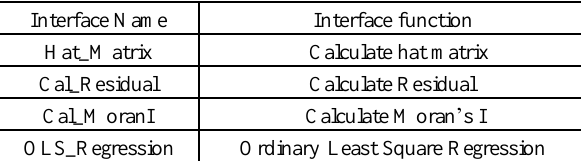
Figure 1. Algorithm flow